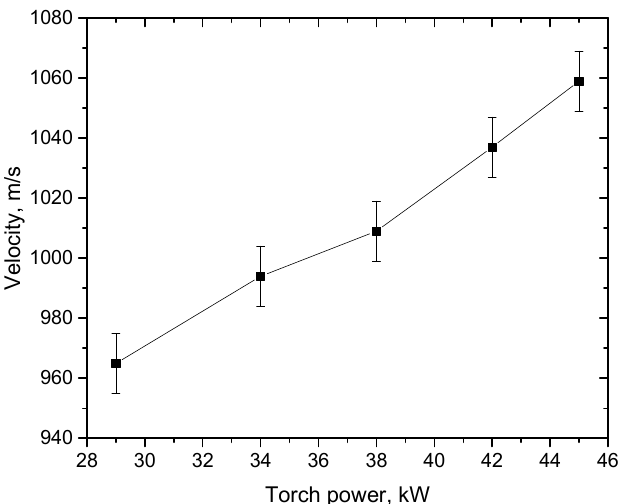
Figure 2. Plasma jet velocity as a function of input power. The velocity of alumina particles was calculated by analyzing video footage of plasma spray, captured by a high-speed camera at 60,000 frames per second with 16 μ s